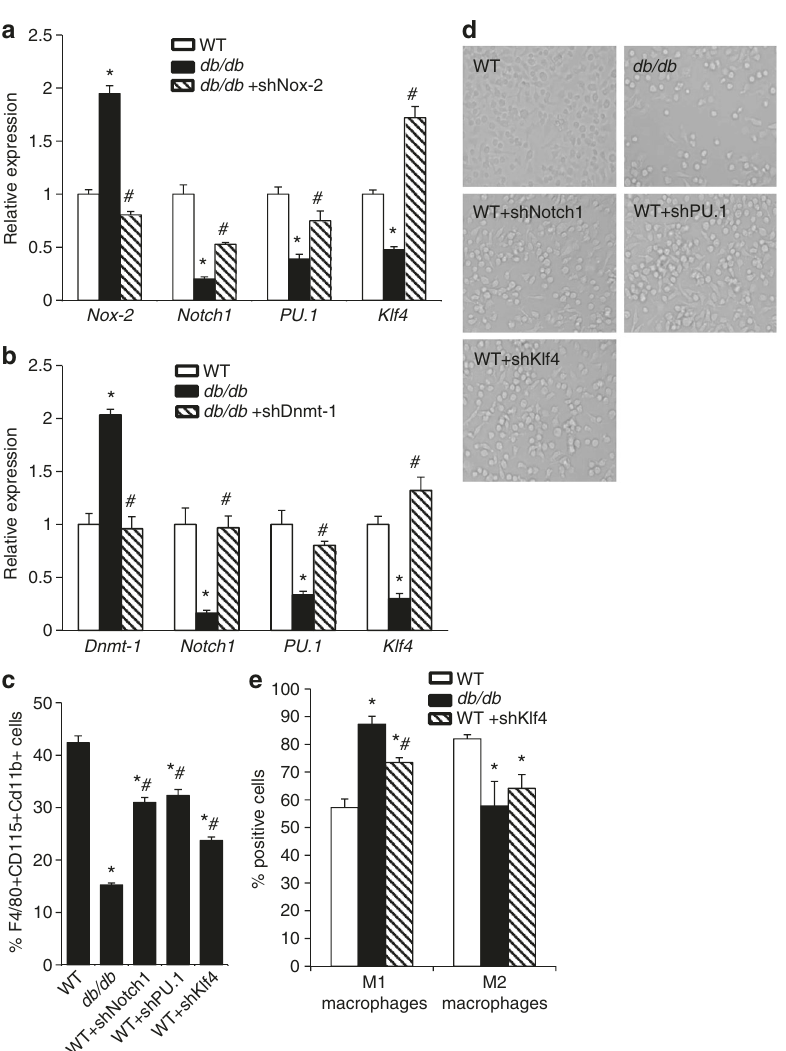
Fig. 7 Oxidant stress-dependent downregulation of Klf4 , PU.1 , and Notch1 . Gene expression analysis following. a Nox-2 knockdown ( n = 6. * p < 0.05 vs. WT; # p < 0.05 vs. db/db ). b Dnmt1 knockdown ( n = 6. * p < 0.05 vs. WT; # p < 0.05 vs. db/db ). c Flow cytometry analysis of HSC-induced differentiation towards macrophages under in vitro conditions ( n = 6, * p < 0.05 vs. WT; # p < 0.05 vs. db/db ). d Representative images. e Flow cytometry analysis of M1/M2 macrophages ( n = 6. * p < 0.05 vs. WT; # p < 0.05 vs. db/db ). Results are expressed as means ± SEM. One way ANOVA was used for a – c ,